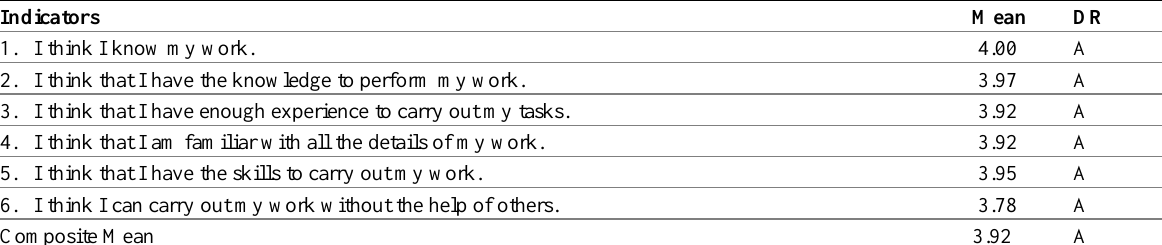
Table 1: The Attitude of Employees toward their work in terms of Cognitive